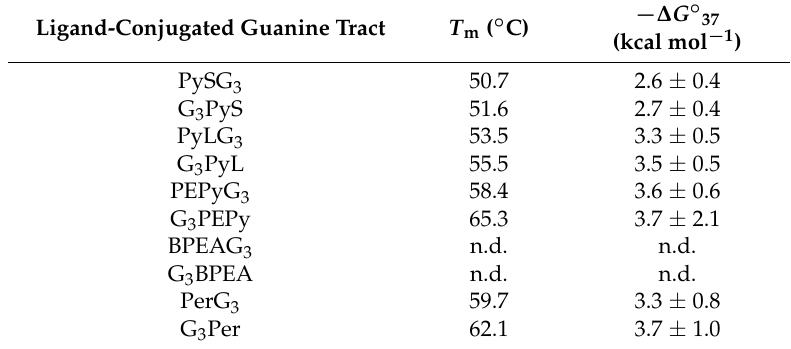
Table 2. Thermodynamic parameters of the VEGF G2T G4 with different ligand-conjugated guanine tracts a .